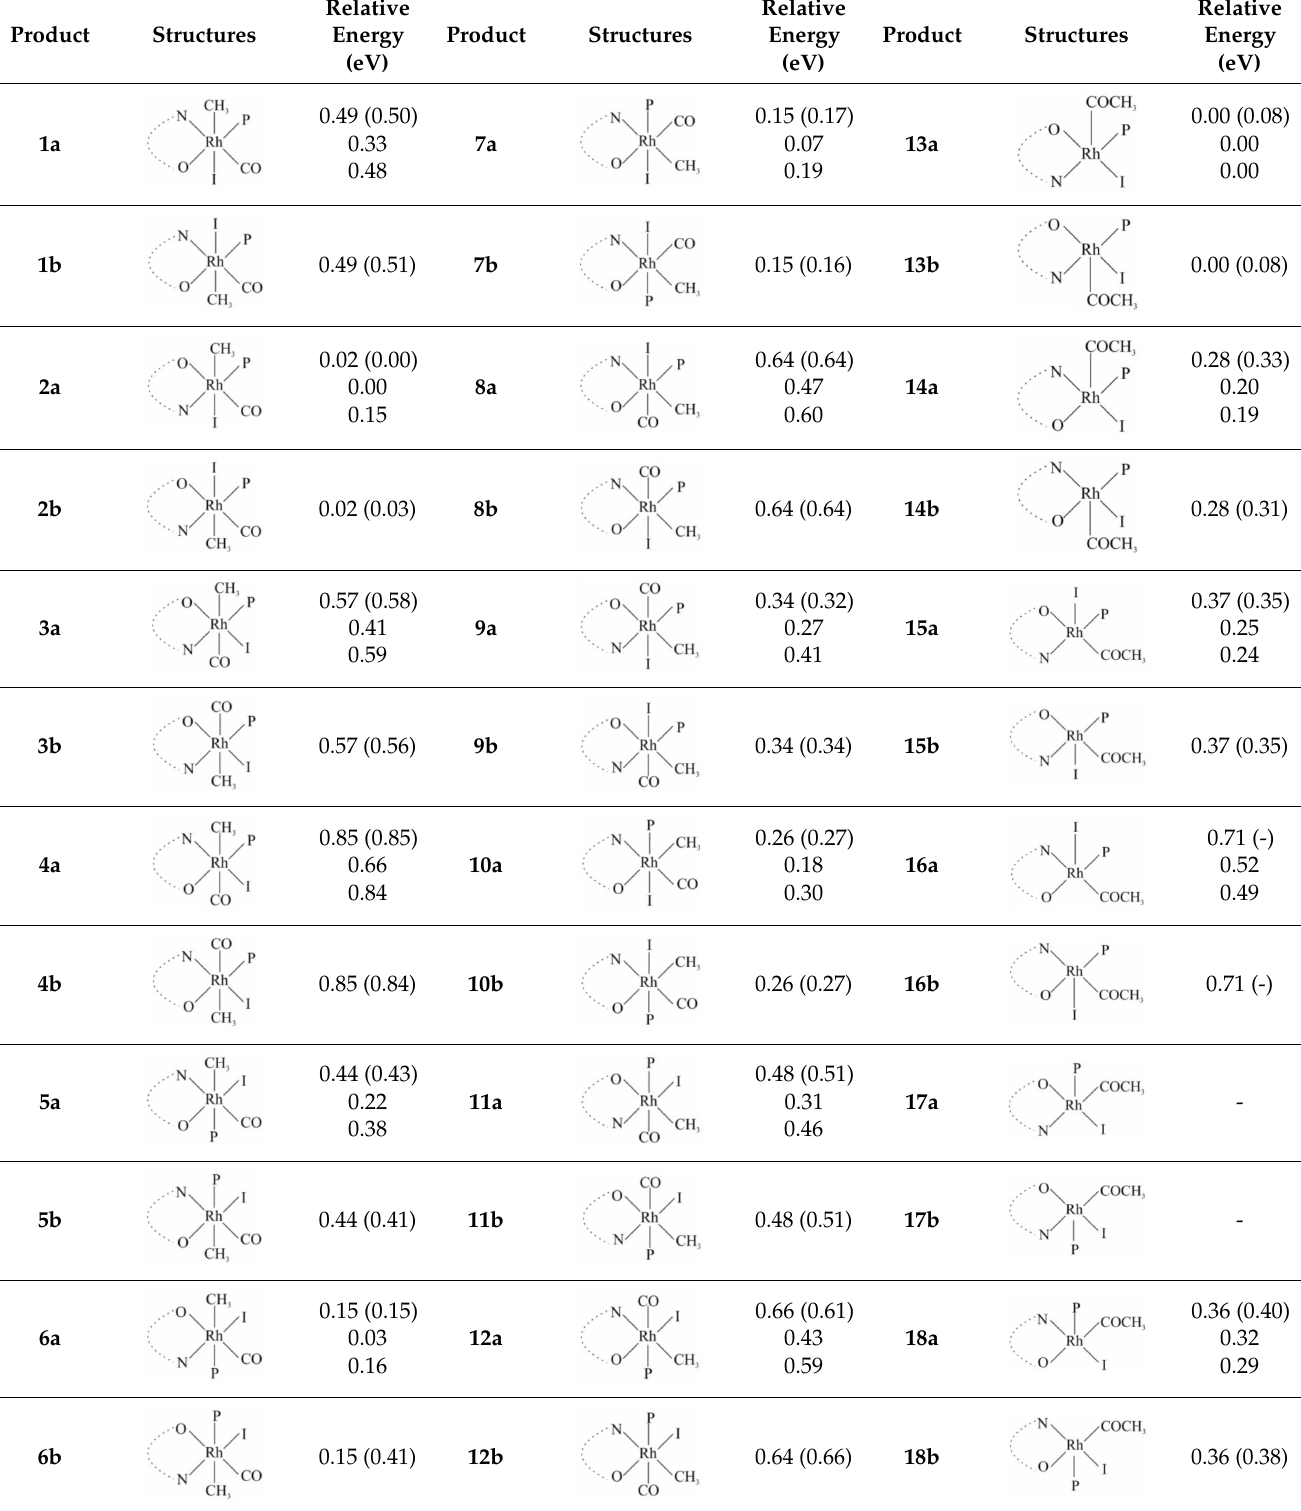
Table 2. Calculated energies (using different DFT methods) and structures of the possible alkyl (1–12) and acyl (13–18) products of the oxidative addition reaction [Rh(CH 3 COCHCNPhCH 3 )(CO)(PPh 3 )] 3B + CH 3 I. In each cell, the top entry gives PW91/TZP (PW91/TZP ZPE, corrected in